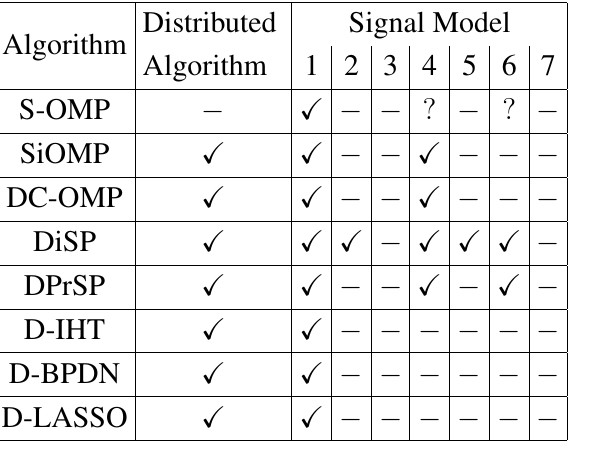
Table 1. Applicability of distributed algorithms. S-OMP, simultaneous orthogonal matching pursuit; SiOMP, side-information-based OMP; DC-OMP, distributed and collaborative OMP; DiSP, distributed subspace pursuit; DPrSP, distributed predictive SP; D-IHT, distributed iterative hard thresholding; D-BPDN, distributed basis pursuit denoising; D-LASSO, distributed least absolute shrinkage and selection operator. Distributed Signal Algorithm Algorithm